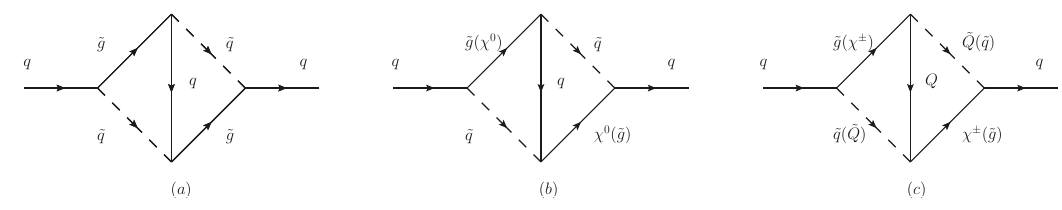
and d g are obtained by attaching a q q